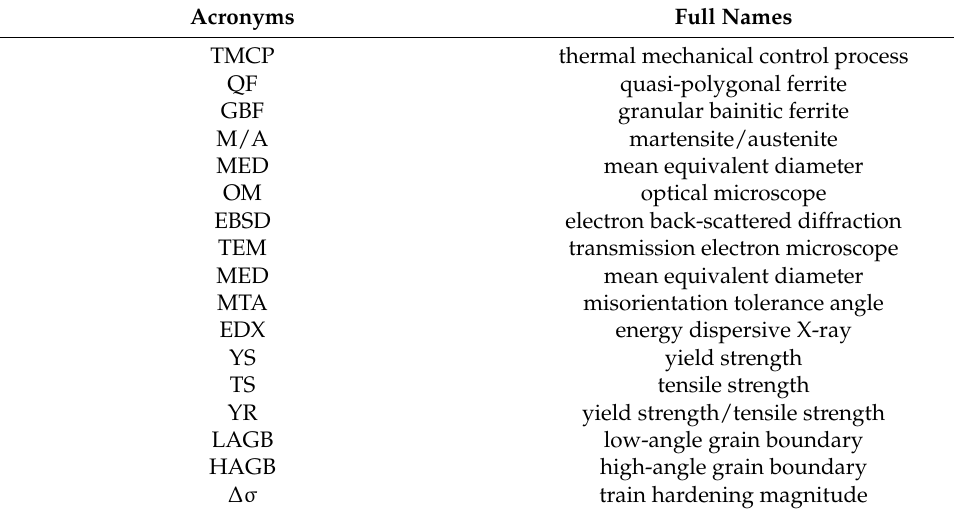
Table A1. Acronyms and their full